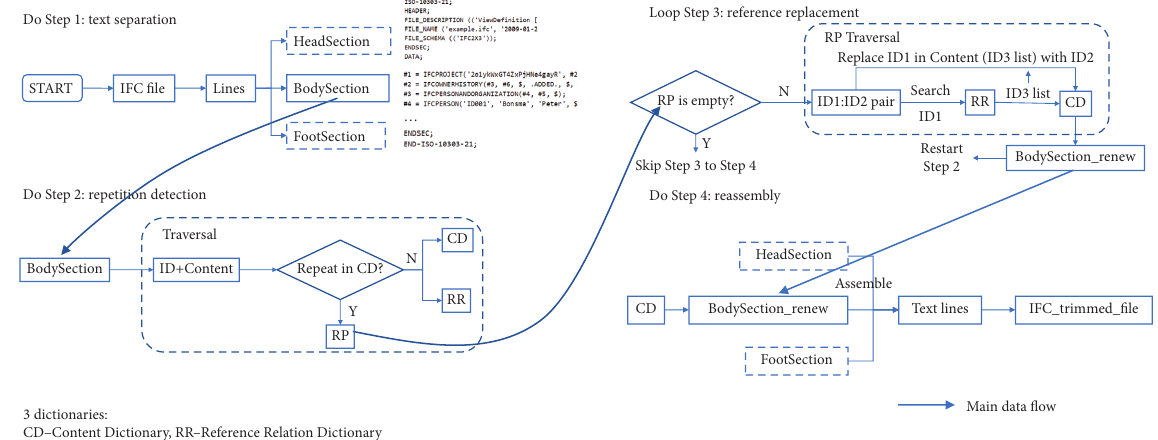
Figure 5: Data flowchart for duplicate removal of IFC-SPF.